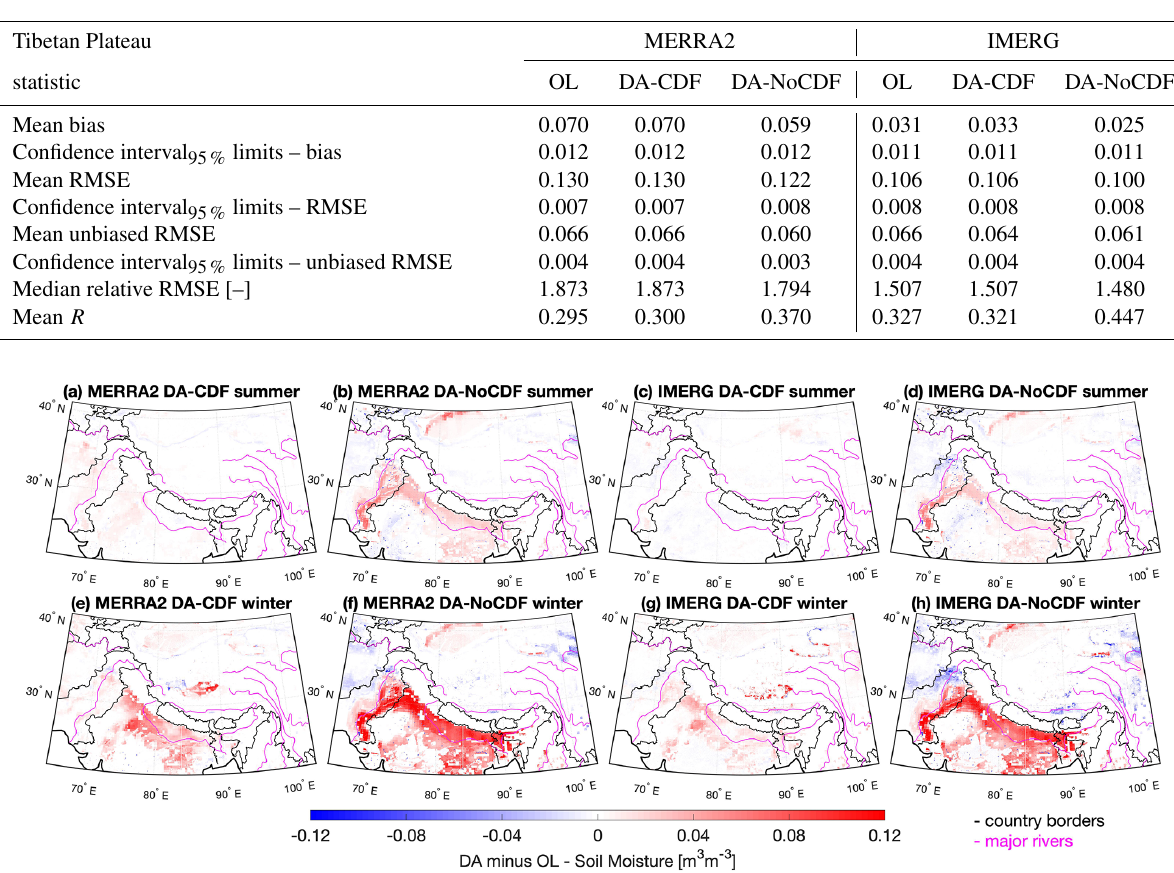
x axis (here OL). Forest (Fig. 5a), savannas (Fig. 5c),